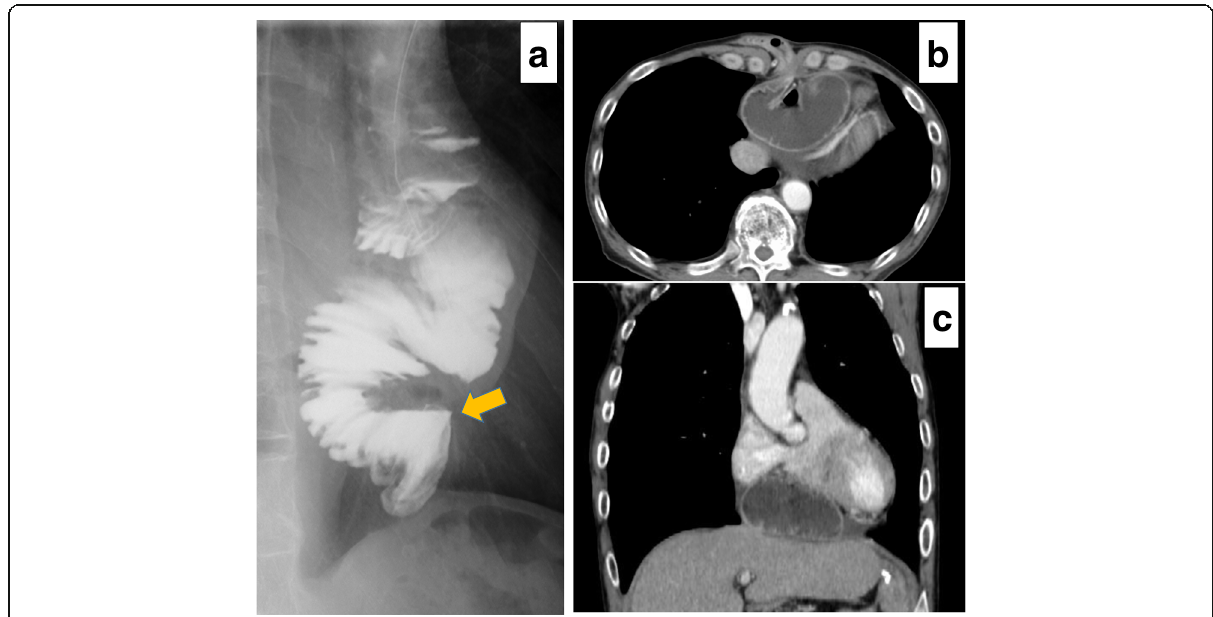
Fig. 2 a The pedicled jejunum through the antethoracic route shows the beak sign (arrow) in the enteral contrast study. b Transverse and c sagittal enhanced computed tomography images demonstrate the intrapericardial migration of the small bowel anterior to the heart